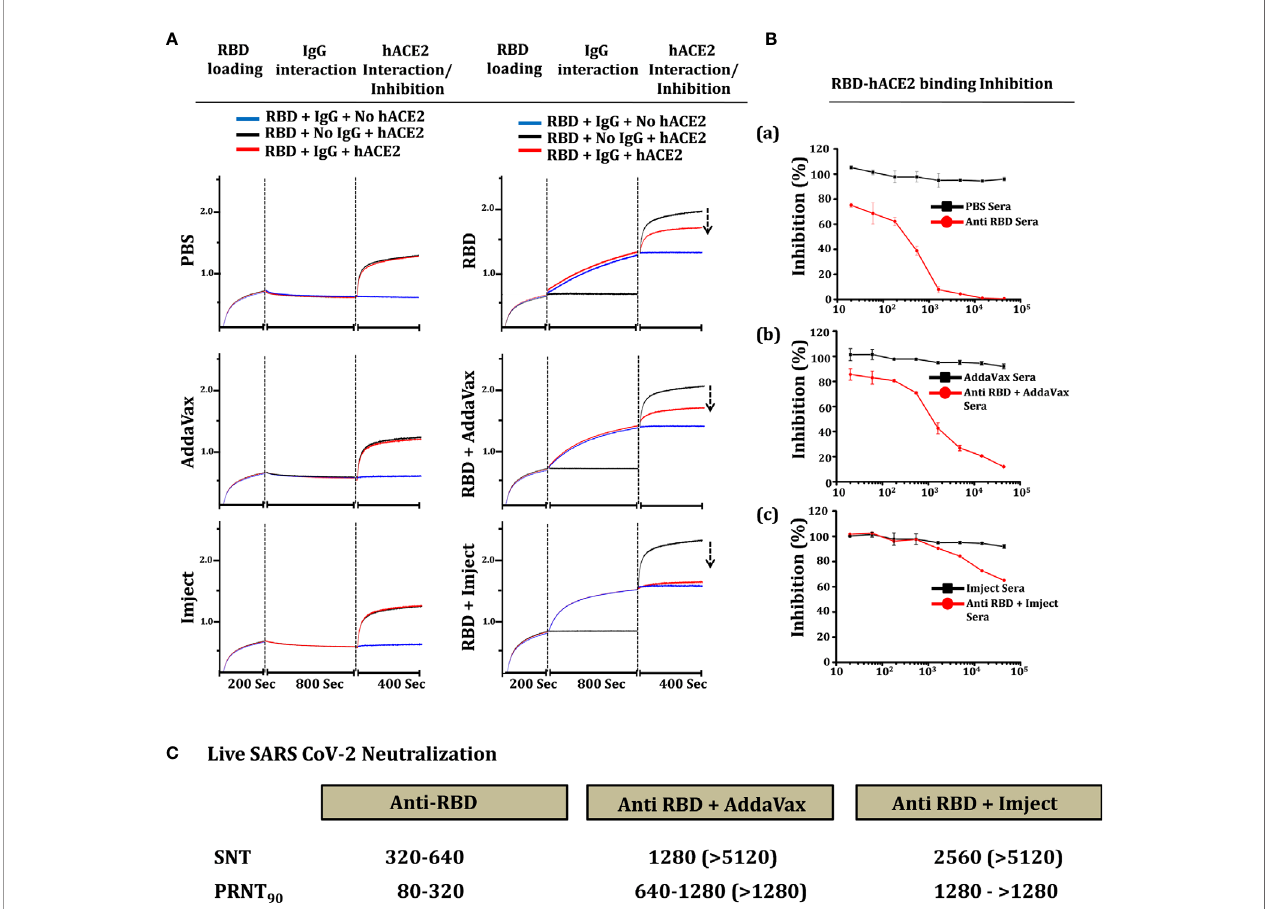
FIGURE 7 | hACE2 competition, inhibition, and neutralization antibody titer estimation. (A) Competition of RBD-immunized sera IgG (right) and control group sera IgG (left) with hACE2 to bind to RBD. The section of vertical dashed lines indicates RBD-Fc loading, the start of the IgG association to RBD and complex formation, and free RBD and RBD-IgG complex solid-phase ACE2 interaction. The solid-phase hACE2 interaction was normalized to evaluate the reduction in RBD-IgG complex-hACE2 interaction. (B) Inhibition of RBD-Fc and hACE2 interaction in the presence of sera from respective control and RBD immunized groups. The percentage of RBD-hACE2 interaction was plotted with reference to control group sera reactivity, a) anti-RBD (RBD alone) sera, b) RBD + AssaVax sera and c) RBD + Imject sera. (C) Live virus neutralization of SARS-CoV-2 virus estimated through plaque reduction neutralization test 90 (PRNT 90 ) and serum neutralization test (SNT) of sera from each individual mouse from the group. The table shows the range of neutralization obtained from the mice in the group, the value bracket shows the highest response obtained from individual mice in the